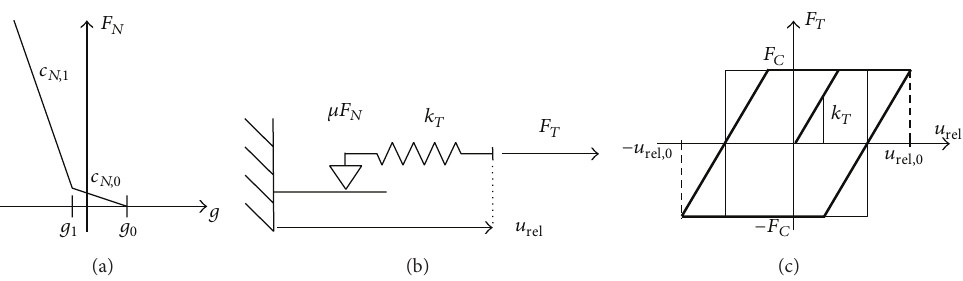
Figure 4: (a) Normal force stiffness relation. (b) 1D Jenkins friction model. (c) Jenkins model hysteresis loop (thick) in comparison to the Coulomb friction hysteresis (thin). Note, that for increasing tangential stiffness, the hysteresis approximates the Coulomb model hysteresis.